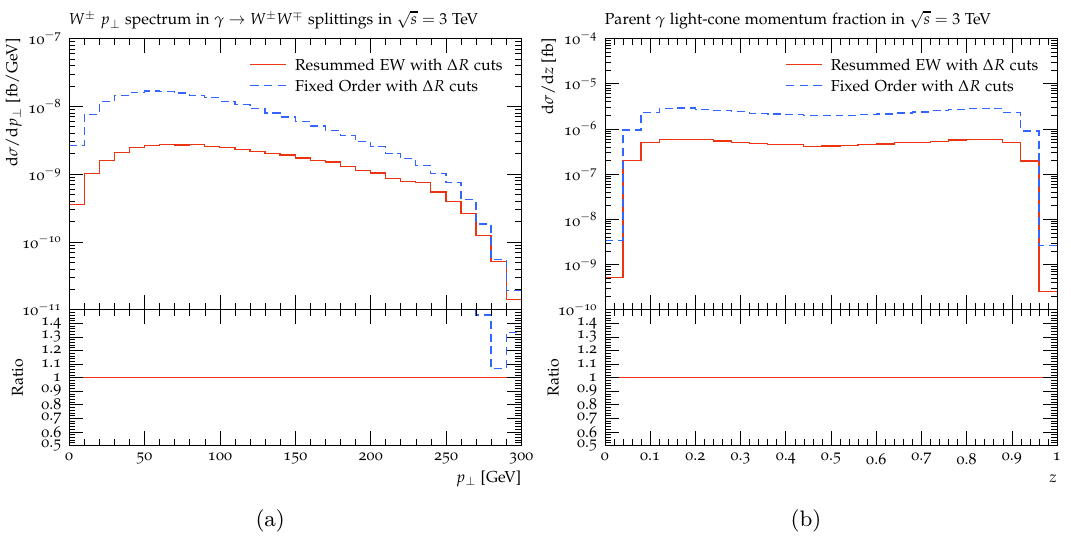
√ s = 3 TeV. A lower